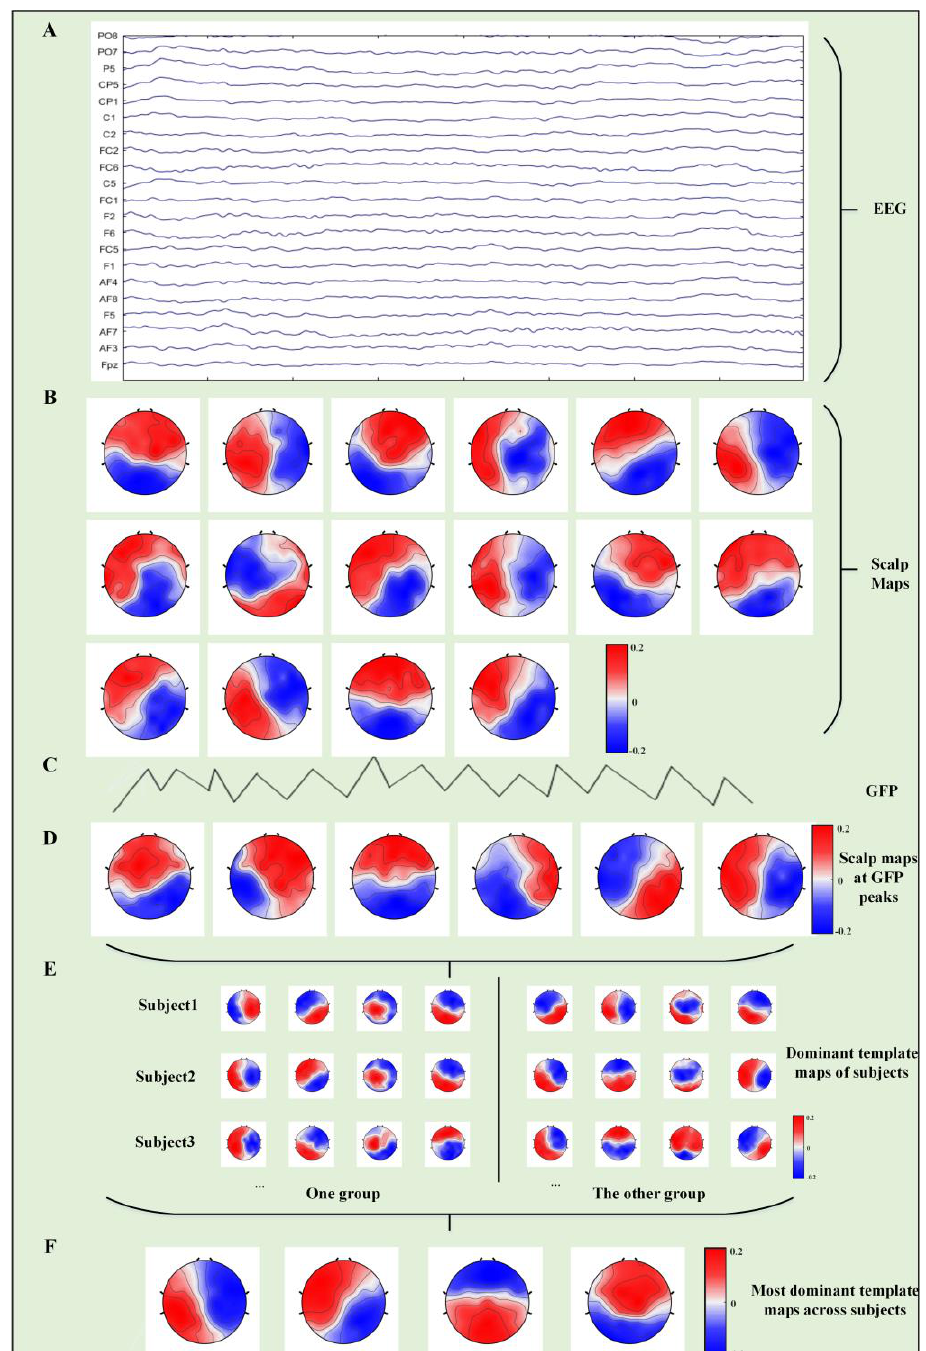
Figure 1. Electroencephalogram (EEG) microstate analysis. ( A ) Original EEG data. ( B ) Sixteen scalp maps at 0.5 s intervals. ( C ) Identification of the local peaks at the global field power (GFP) curve within 0.5 s intervals. ( D ) The scalp maps corresponding to the local GFP peaks were submitted to an AAHC analysis. ( E ) The dominant template maps for each participant. ( F ) The dominant template maps for the four microstates after group clustering across all participants.